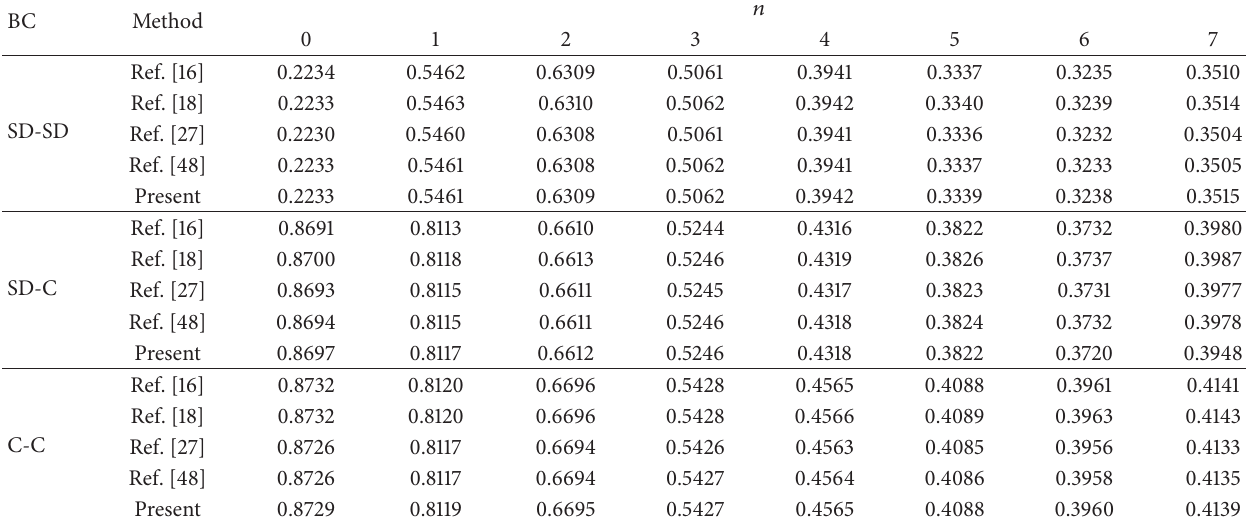
Table 18: Comparison of frequency parameters Ω = 𝜔𝑅 1 √𝜌(1 − 𝜇 2 )/𝐸 for a closed conical shell with different boundary conditions ( 𝑚 = 1 ). BC